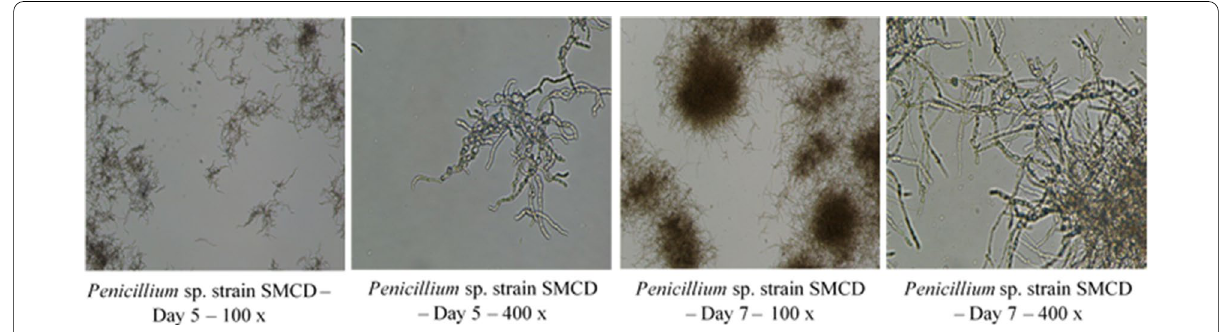
Fig. 4 Microscopic observations of scaled up Penicillium sp. SMCD biomass production in 300-L fermentation with CFU increasing over growth duration (5–7 days). SMCD strains are from Dr. Vujanovic’s Saskatchewan Microbial Collection and